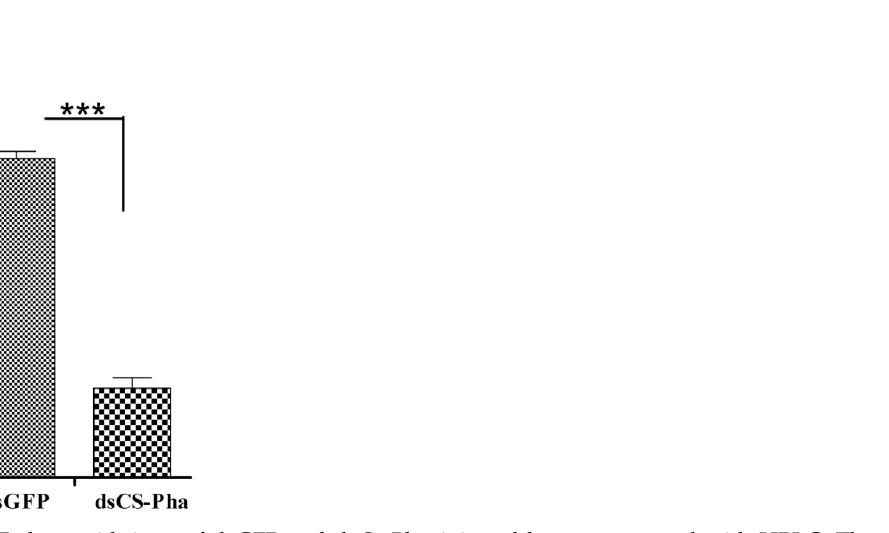
Figure 7. Ecdysteroid titers of dsGFP and ds Cs-Phm -injected larvae measured with HPLC. The columns indicate average values, and vertical bars represent SE. *** indicates statistical differences between treatments at d p < 0.001.